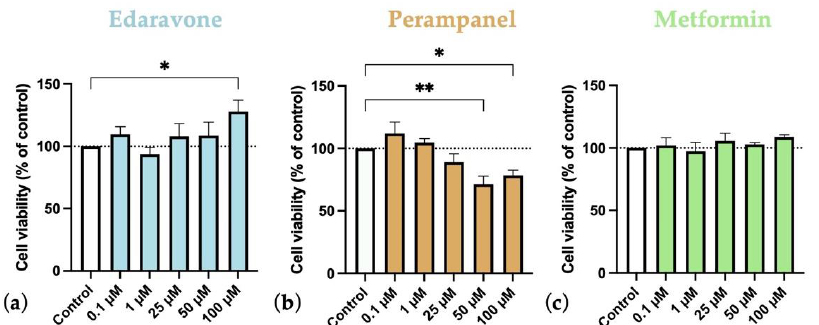
Figure 4. Effects of ( a ) Edaravone, ( b ) Perampanel, and ( c ) Metformin treatment for 48 h on SH-SY5Y cells viability. Cell viability was assessed by MTT assay. Results are expressed as the percentage of cell viability relative to the respective untreated control cells. * and ** indicate p < 0.05 and p < 0.01, respectively, when compared to control. All data are presented as the mean + SEM of three independent experiments.